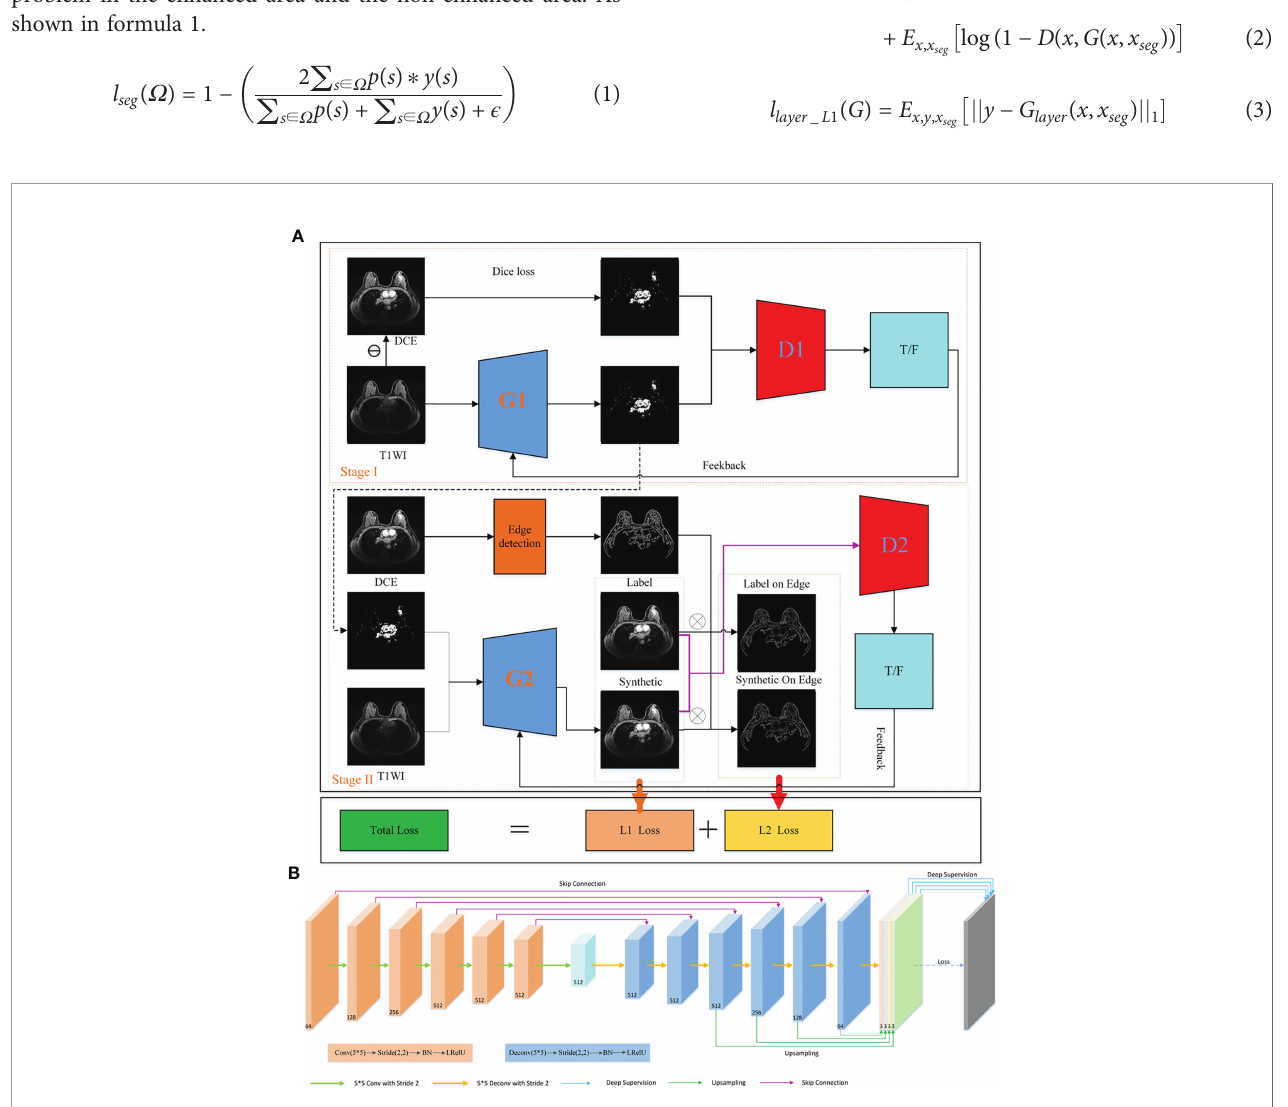
FIGURE 1 | The fl owchart for synthesizing FP-Dyn sequences by using EDLS. (A) A fl owchart for constructing the EDLS model. On stage I, the generator G1 transferred the T1WI image to the images only containing an enhanced area. The D1 discriminator was used to judge the consistency of the synthesized enhanced area image with the original area images. In stage II, synthesized FP-Dyn sequence images were synthesized by a generator G2 from T1WI sequence images and enhanced area images. In addition, the edge loss function was added to ensure the details of the synthesized FP-Dyn sequence image. The loss functions of the EDLS model consist of two parts: L1 Loss and L2 Loss. (B) Showed the structure and detailed parameter information of the generators (G1, G2), and the G1 and G2 had similar structures and parameters. The U-Net was applied to the network architecture of generators, and a deep-supervision strategy was used to optimize the training